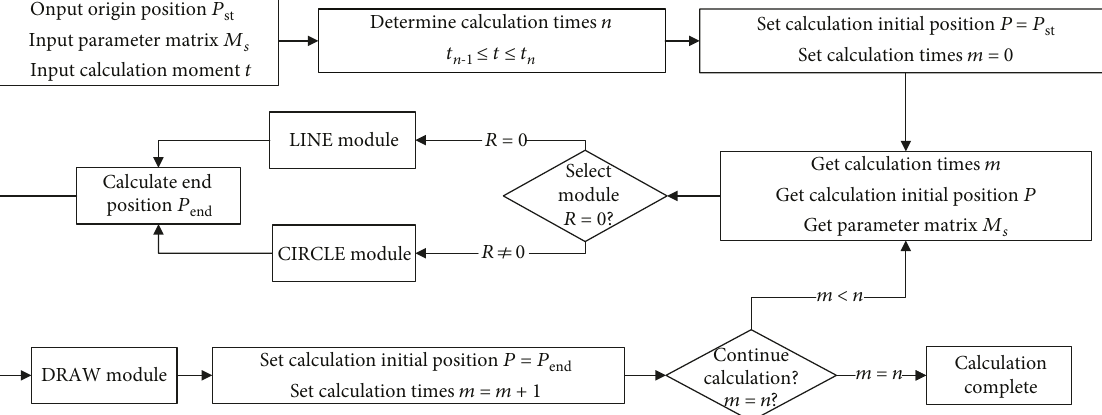
Figure 8: Calculation process and data fl ow in the